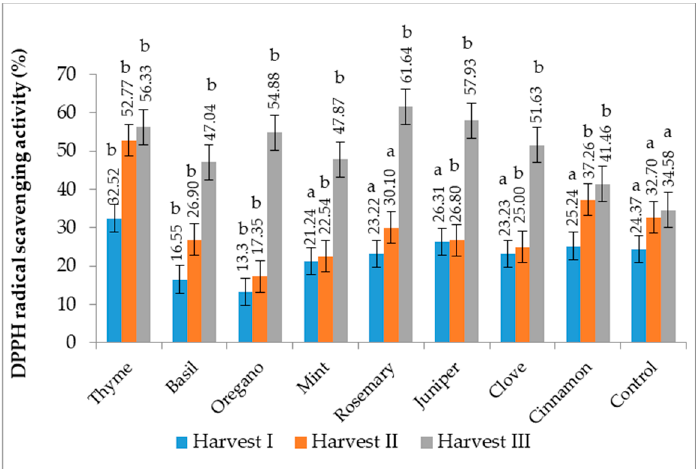
Figure 9. The antioxidant activity of the samples before (Harvest I), after (Harvest II) the use of EOs in the supplementary food of bee families, respectively after the first harvest (rapeseed) (Harvest III). Different letters between control and samples indicate significant differences ( p < 0.05) among these values according to the t -test.